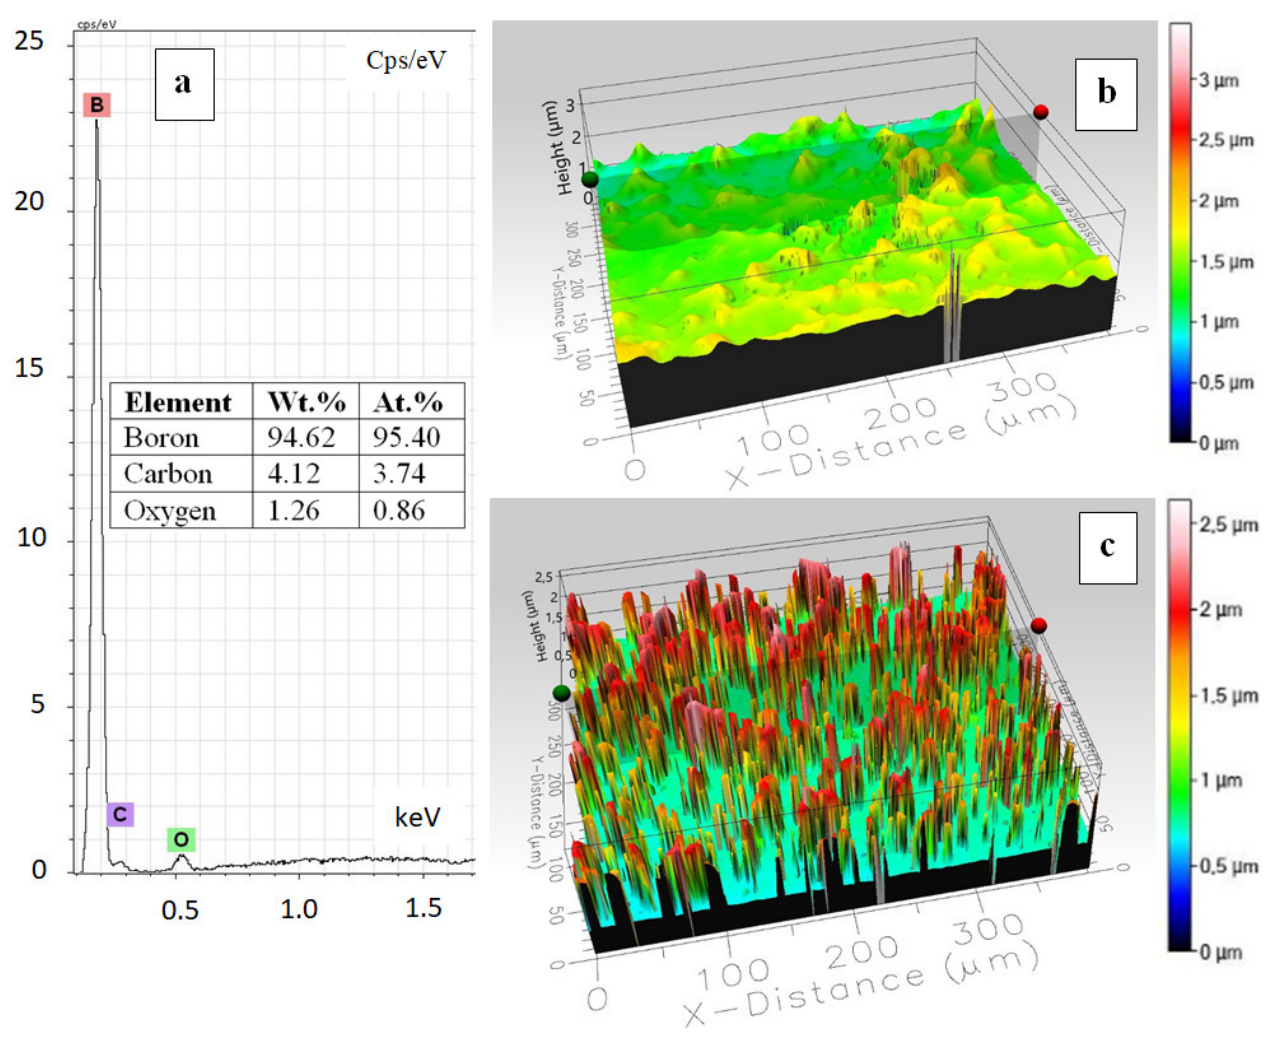
Figure 4. ( a ) Elemental composition of the obtained coatings. The surface profiles of ( b ) boron-based coating and ( c ) boron-based coating after pulse modification in regime 2 measured under a Solver P47 atomic force microscope.